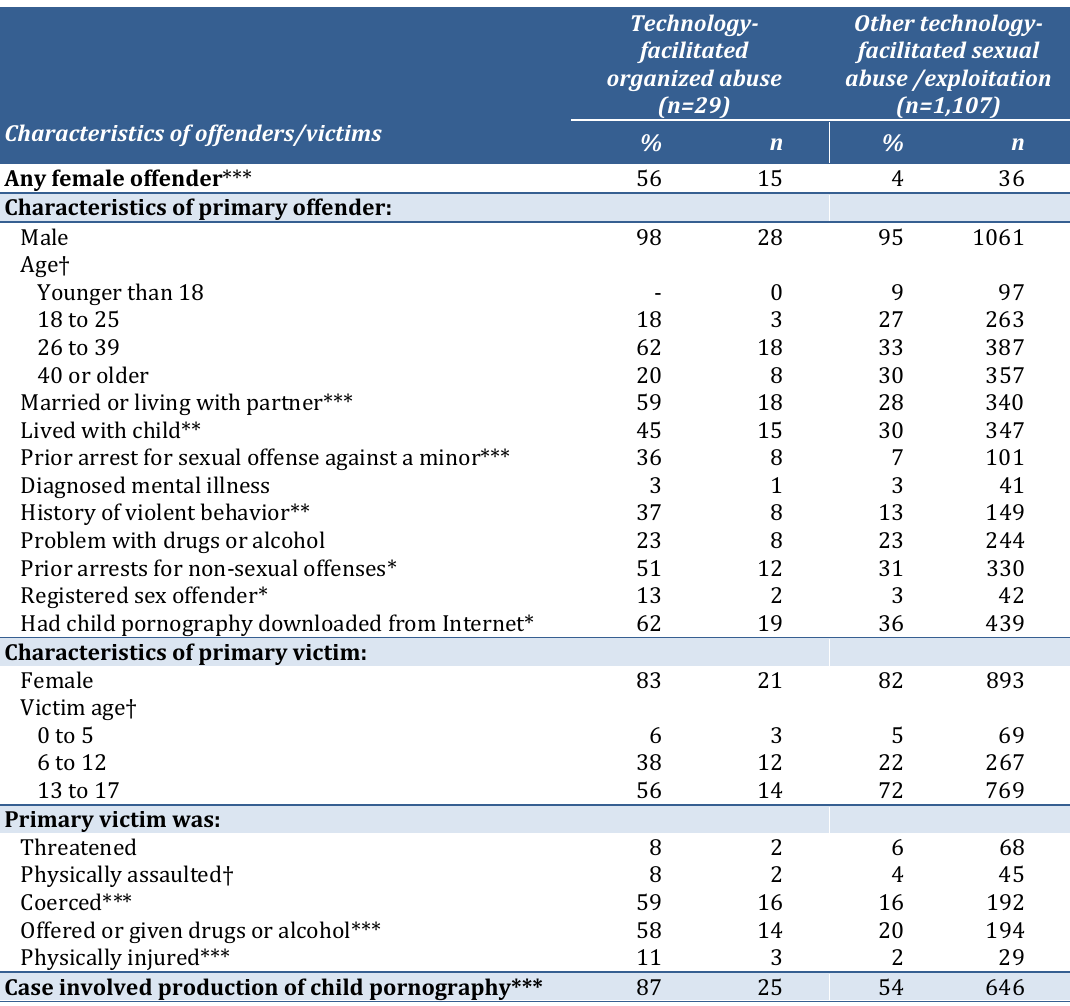
Table 4: Technology ‐ facilitated organized abuse arrest cases compared to technology ‐ facilitated sexual abuse or exploitation not involving organized abuse